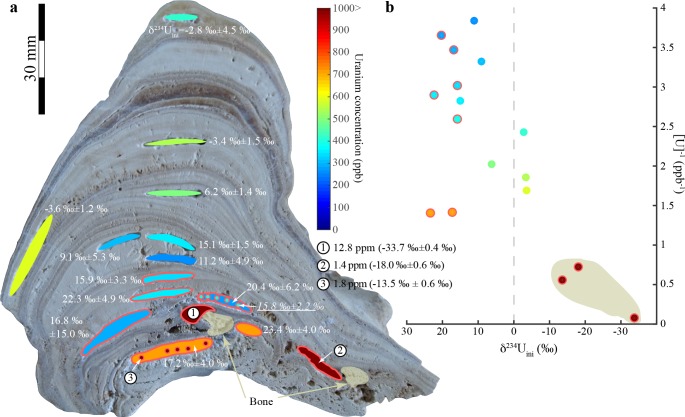
Uranium concentrations and initial δ234U values of CH-7.The U concentration of samples analysed by us is illustrated by warm/cool coloured frames indicating higher/lower U concentrations (a) Samples 1–3 present the highest U concentrations and lowest initial δ234U values. (b) The relationship between the U concentrations and the initial δ234U values show that samples with highest U concentrations are generally low in initial δ234U. This is likely caused by the influence of the pelvic bone, causing a U gain and at the same time a decrease in 234U/238U.